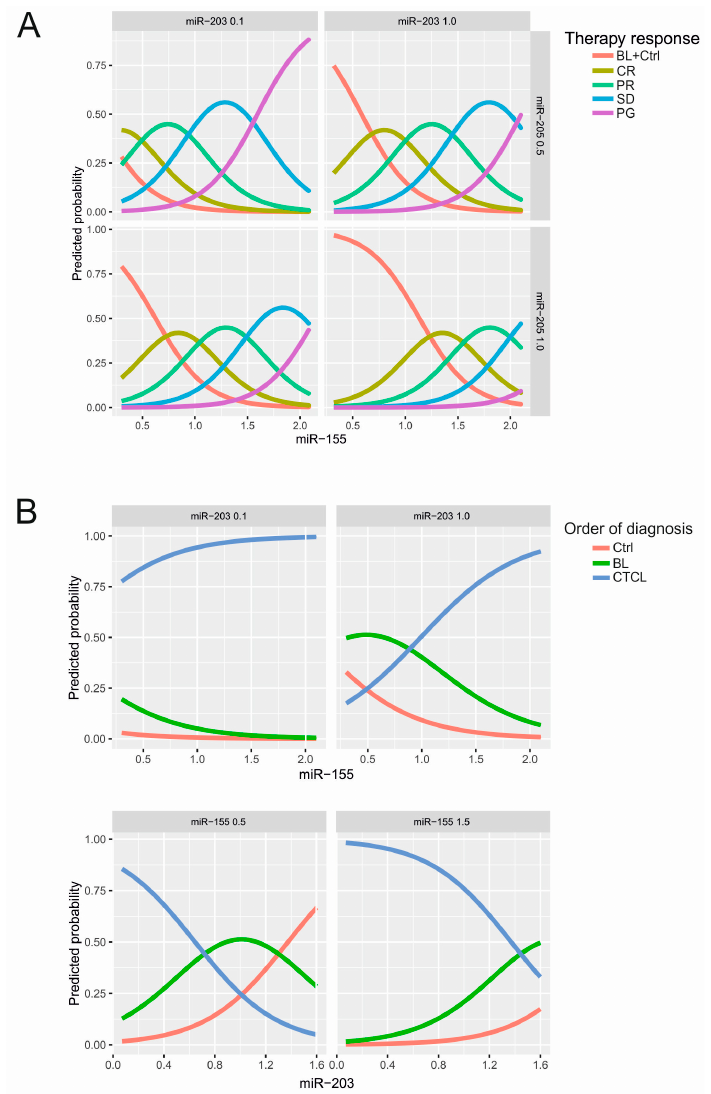
Figure 5. Predicted probability of therapy response and diagnosis based on miR levels. ( A ) Predicted probability that a patient has a particular therapy response (CR, PR, SD, PG) or belongs to the BL/healthy control. The X -axis provides miR-155 level at certain levels of either miR-203 (0.1 vs. 1.0) or miR-205 (0.5 vs. 1.0); ( B ) predicted probability that a patient is healthy, benign, or malignant (Ctrl < BL < CTCL, i.e., ordered diagnosis) based on the ordered logistic regression model. Increasing miR-155 ( X -axis) increase the probability of belonging to the CTCL category seen at two levels of miR-203. Bottom panel: accordingly, decreasing miR-203 ( X -axis) increase the probability of belonging to the CTCL category seen at two levels of miR-155 (0.5 vs. 1.5).